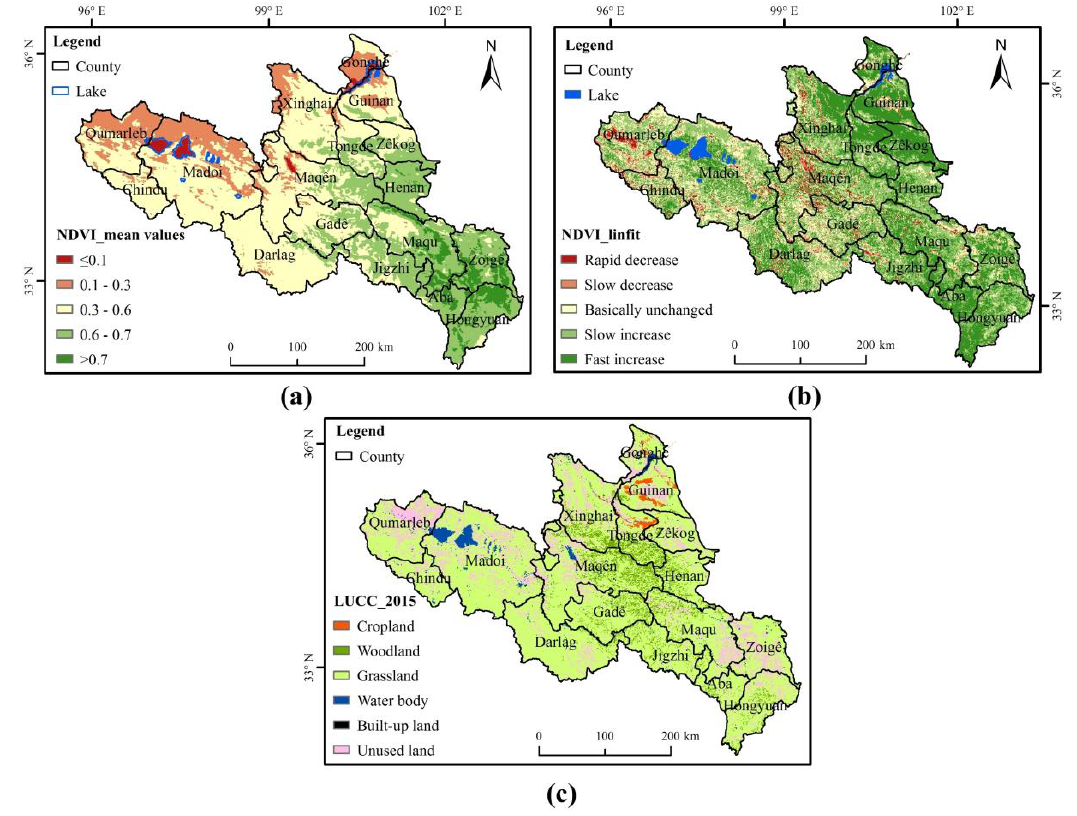
Figure 2. Spatial distribution in the SRYR from 1998 to 2016: ( a ) mean NDVI value; ( b ) NDVI change trend; ( c ) land-use types in 2015. In Figure 2b, rapid decrease represents a slope < –0.003; slow decrease represents –0.003 < slope < –0.001; basically unchanged represents –0.001 < slope < 0.001; slow increase represents 0.001 < slope < 0.003; rapid increase represents a slope < 0.003.